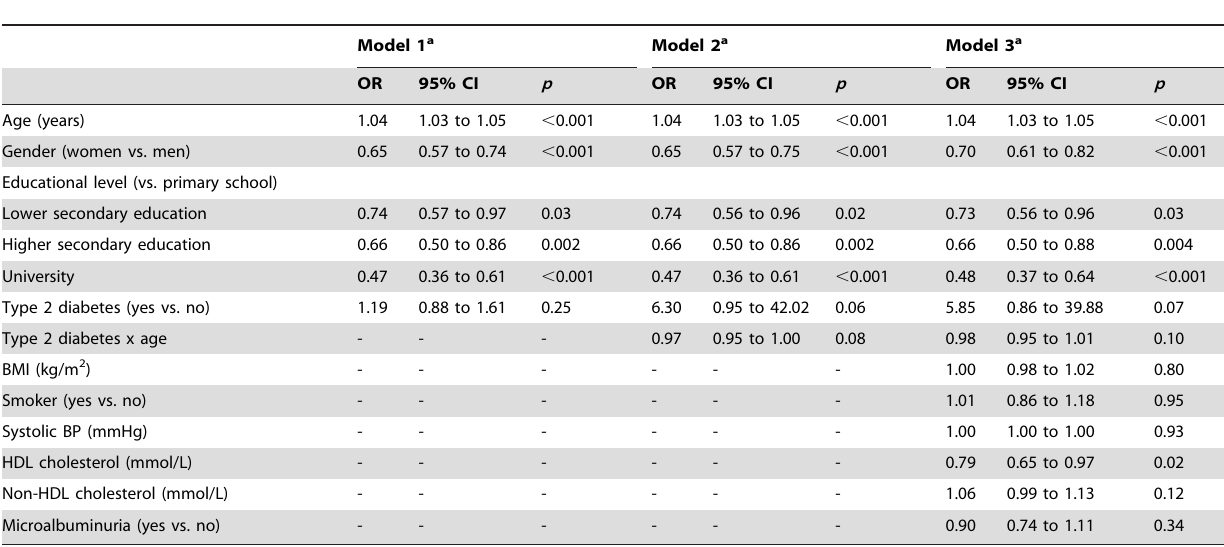
Table 3. Logistic regression analysis of low Visual Association Test performance on type 2 diabetes and